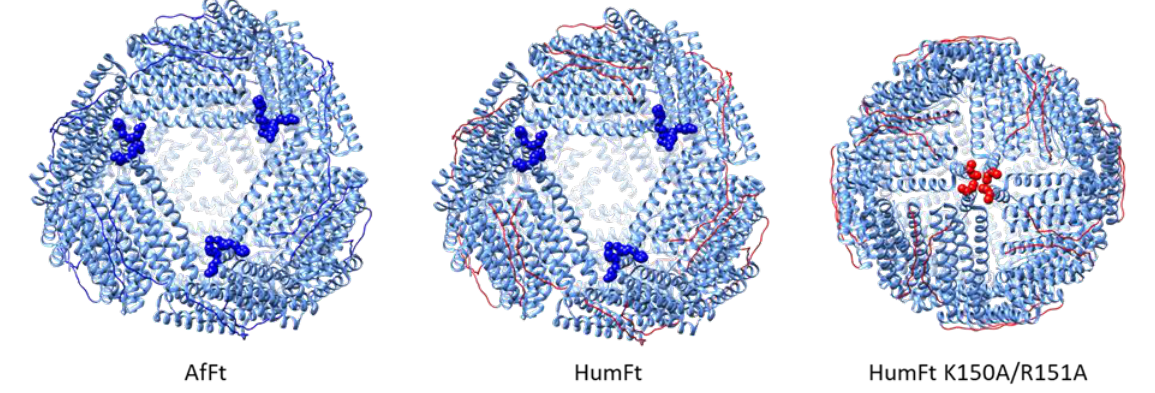
Figure 1. Structure of A. fulgidus ferritin (AfFt, pdb code 1S3Q), humanized A. fulgidus ferritin (HumFt, pdb code 5LS9) and humanized A. fulgidus ferritin double mutant (HumFt K150A/R151A, homology-modeling based on pdb codes 3KX9 and 5LS9). HumFt was obtained by grafting on AfFt the human H ferritin’s BC loops (red loops). HumFt K150A/R151A derives from HumAfFt replacing K150 and R151 (highlighted in blue) with two alanine residues (highlighted in red). This double substitution results in the closure of the triangular pores.